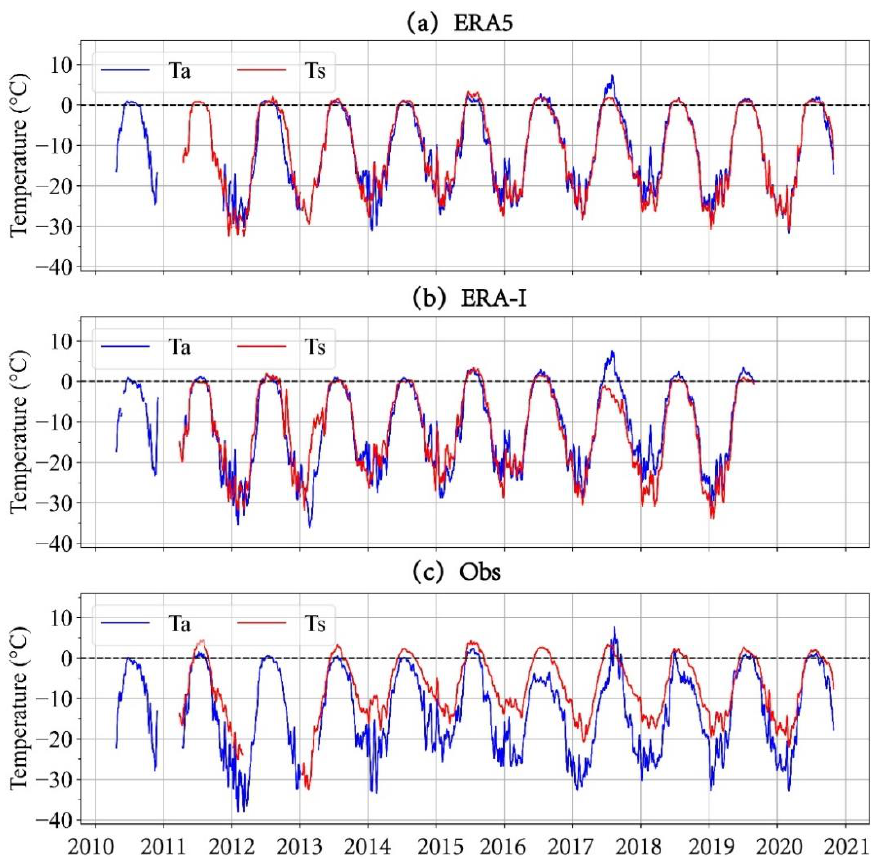
Figure 10. The comparisons of the daily mean Ta and Ts values from ( a ) ERA5, ( b ) ERA-I, and ( c ) the buoy observations during 2010–2020.